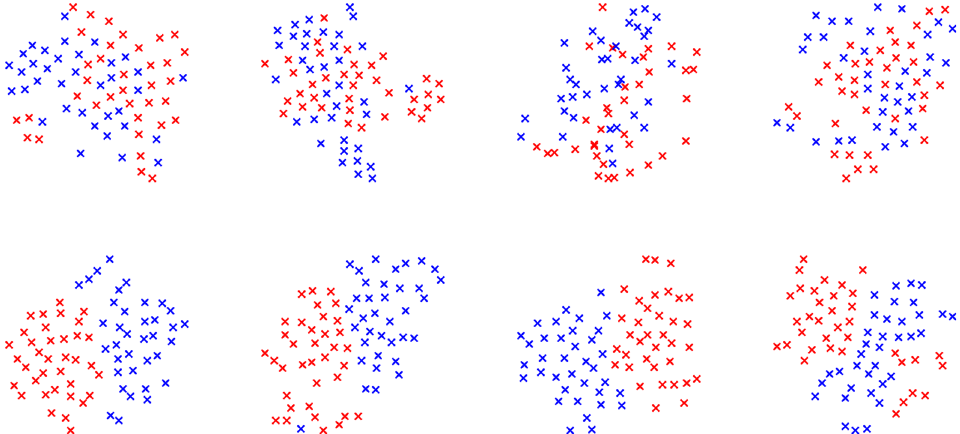
Figure 7. t-SNE based data comparison of four random subjects projected in the CSP space, without (first row) and with (second row) the Filter Bank. Filter Bank improves the classes (blue and red) separability.